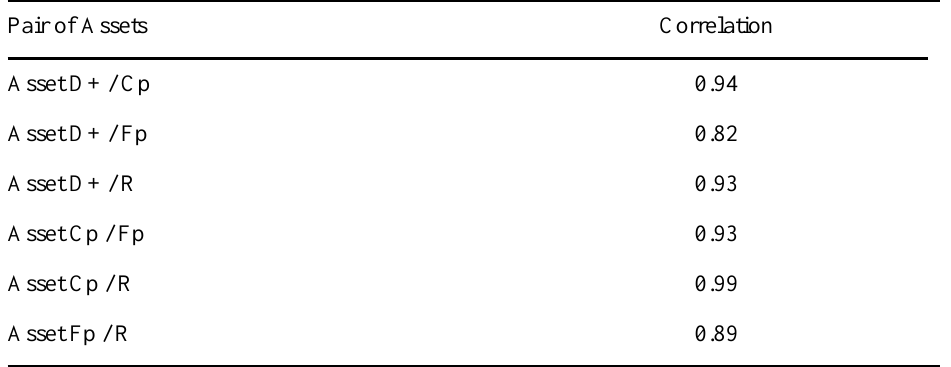
Table 3. Correlation coefficients between pairs of assets using Eq.